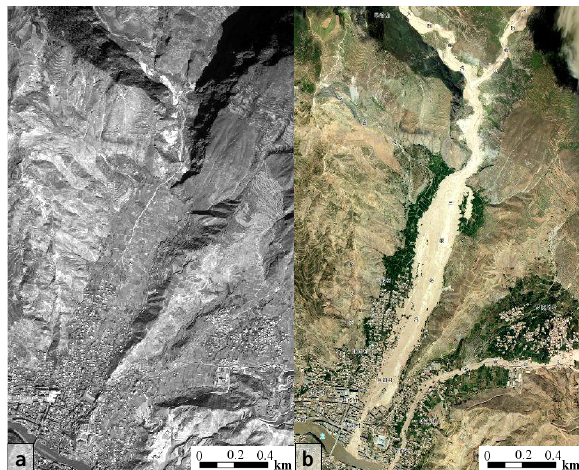
Fig. 11. Alluvial fan prior to and after the debris flow event. ( a : Worldview image taken on 16 May 2010 prior to the event, showing the densely urbanized area in Zhouqu city; b : Quickbird image taken on 15 August 2010 after the Zhouqu debris flow event, showing the depositional zone of the debris flows. New debris flow deposits can be easily distinguished by their lighter tone.)